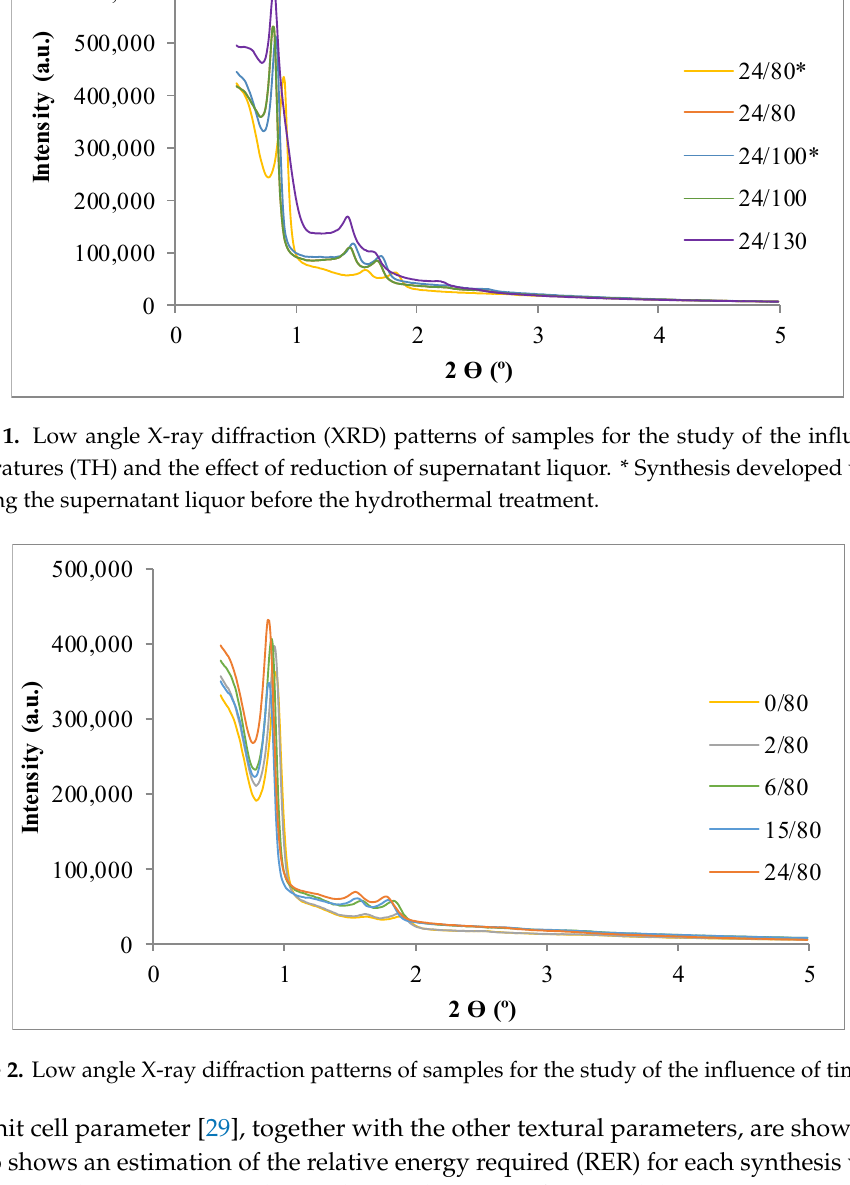
Table 1. Structural properties of the samples obtained at different hydrothermal treatment times and temperatures.